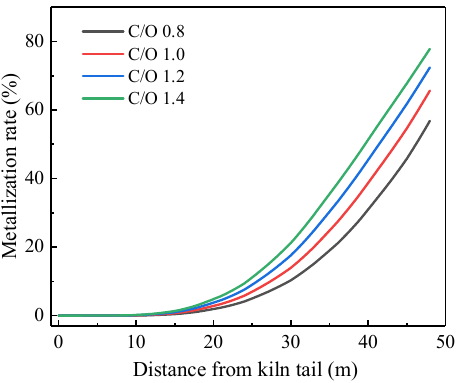
Figure 13. Metallization rate along the axial section for different C/O mole ratio.